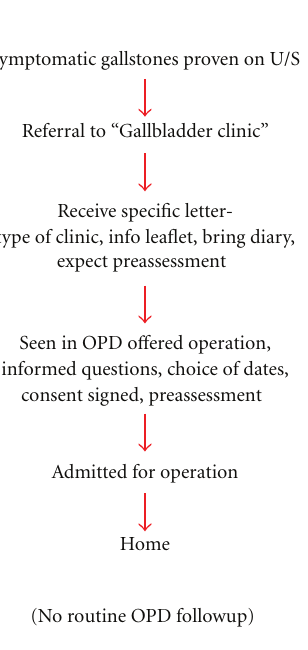
Figure 2: New gallbladder patient pathway introduced in February